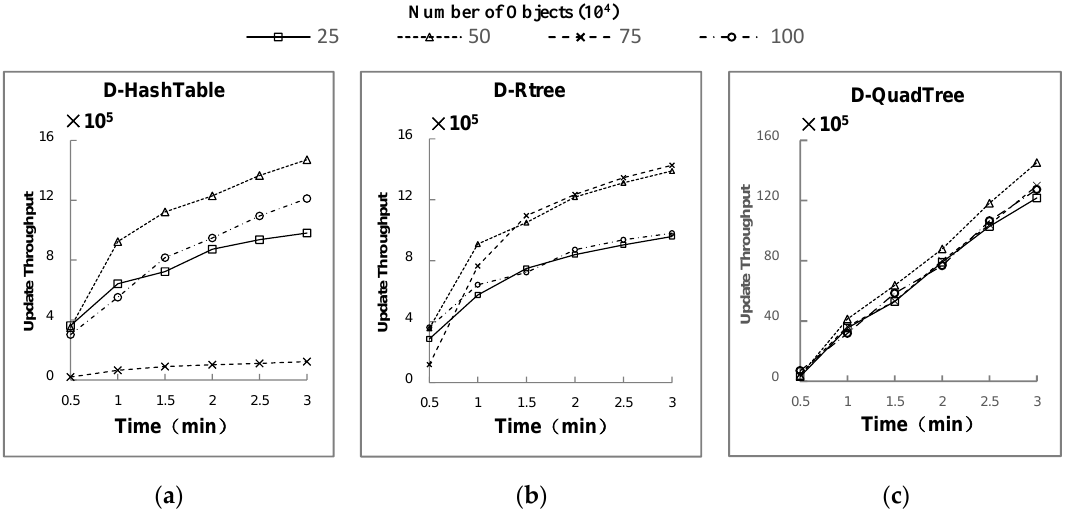
Figure 9. Effect of the number of objects on the spatial join update throughput. ( a ) Update throughput of D-Hahtable; ( b ) update throughput of D-Rtree; ( c ) update throughput of D-Quadtree. • Study 3 ： Influence of the number of grid cells on the spatial join performance